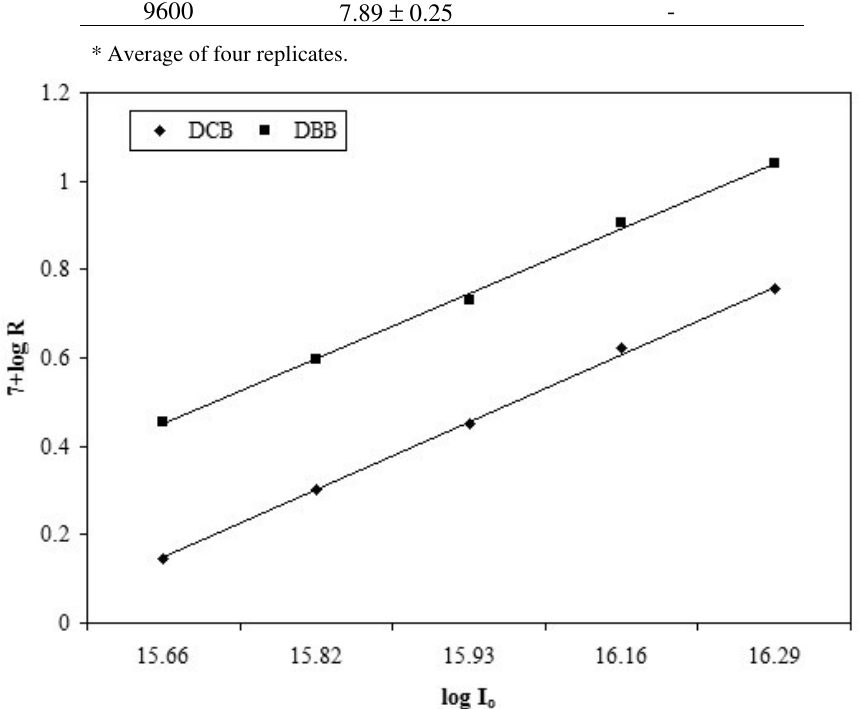
Figure 2. Plot of 7+logR versus log I o